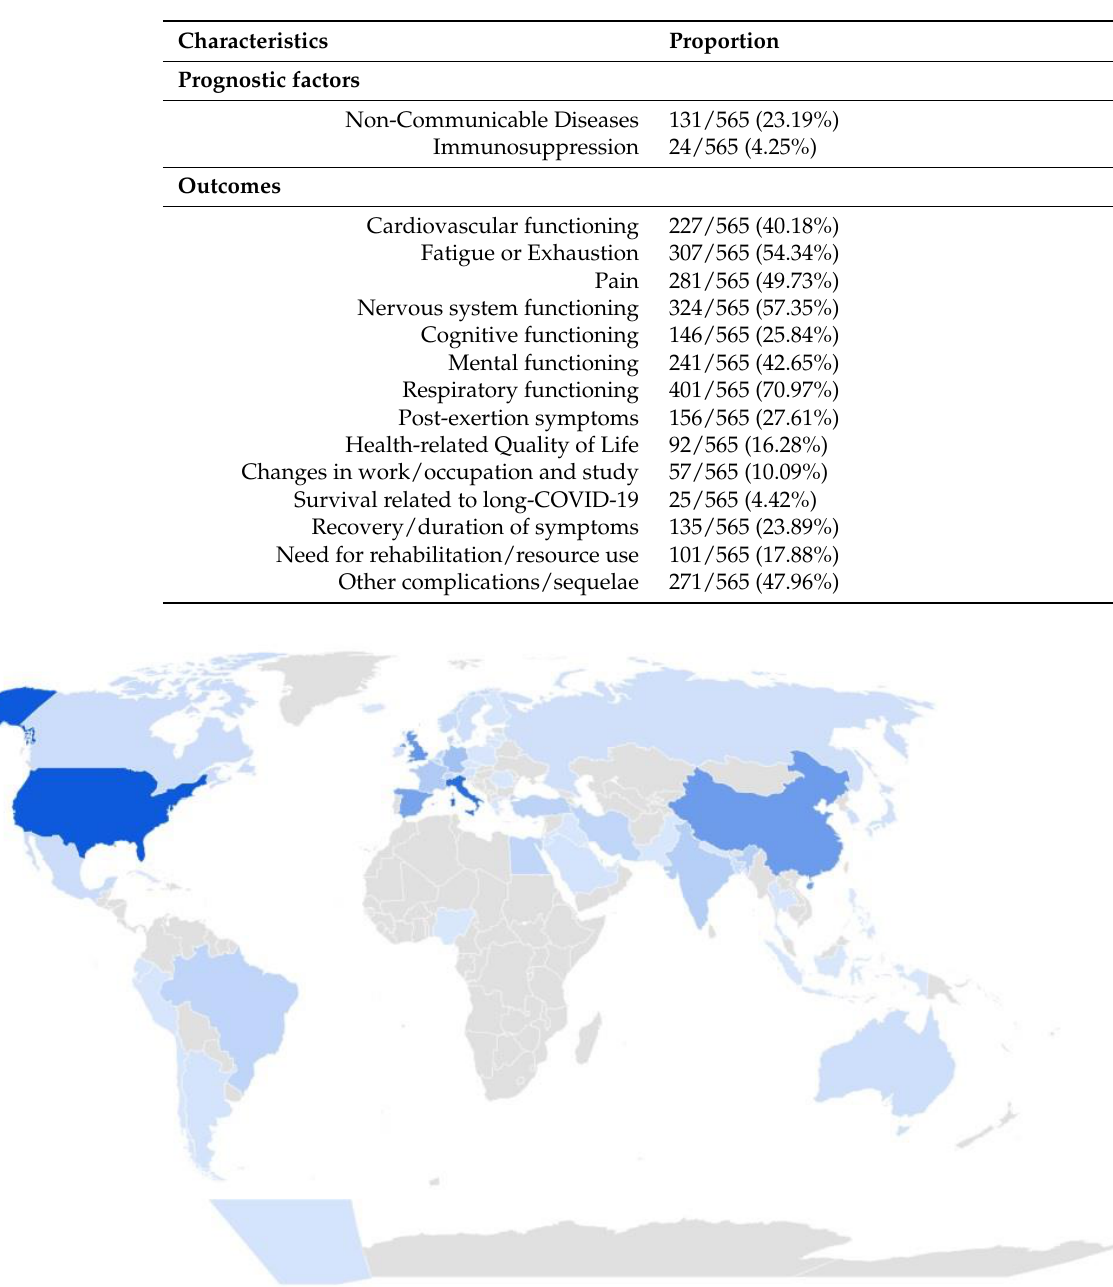
Figure 2. Distribution of studies per country (darker blue indicates a higher density of studies). Footnotes: Darker blue indicates a higher density of studies per country. The top 10 countries with the highest number of studies included the United States (87), Italy (75), the United Kingdom (50), China (47), Spain (42), Germany (24), France (18), India (16), Turkey (13), and Brazil (12). Figure 3 is a screenshot of a section of one of our evidence maps resulting from this research. More maps are available at www.rki.de/post-covid-evimaps (accessed on 10 August